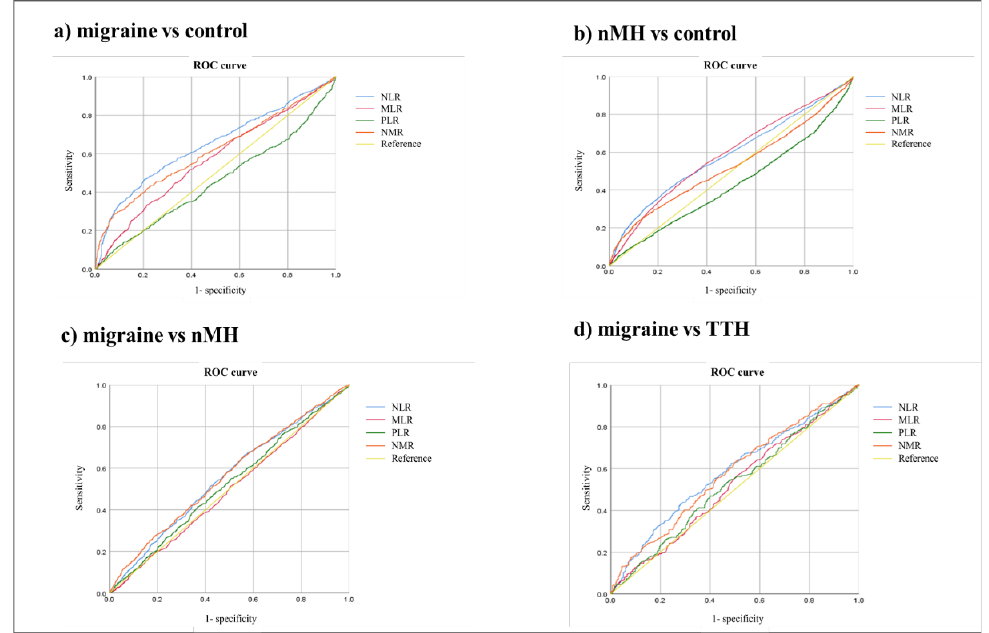
Figure 2. ROC curves of peripheral inflammatory markers for differentiating between groups. ROC, receiver operating characteristic; NLR. neutrophil-to-lymphocyte ratio; MLR, monocyte-to-lymphocyte ratio; PLR, platelet-to-lymphocyte ratio; NMR, lymphocyte-to-monocyte ratio; nMH, non-migraine headache; TTH, tension-type headache.